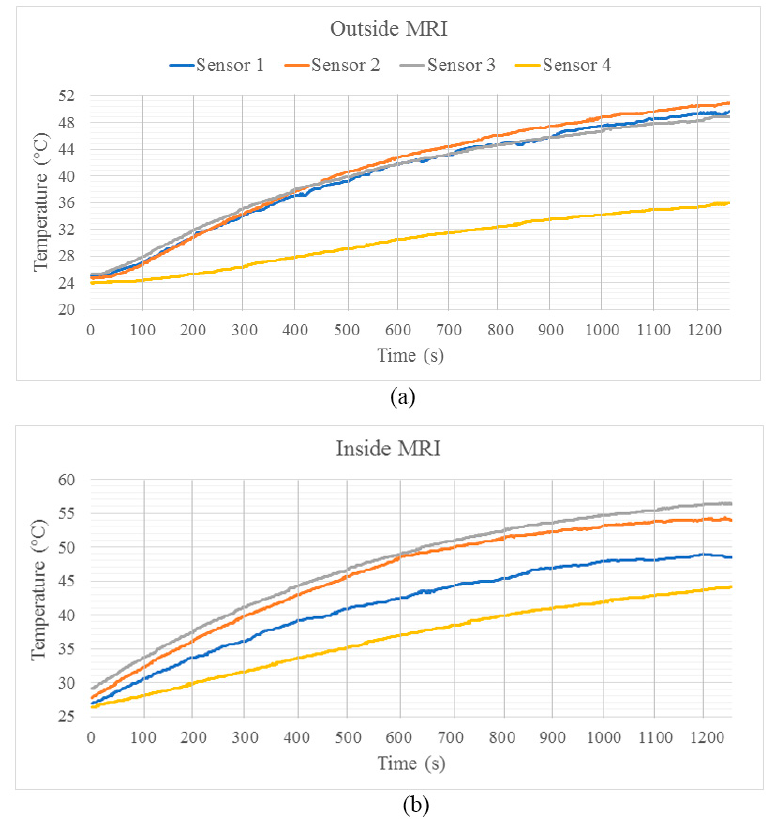
Figure 6. ( a ) Temperature of the operating ultrasonic motor (USM) outside the magnetic resonance imaging (MRI) system; ( b ) Temperature of the operating USM inside the bore when the scanner was on.